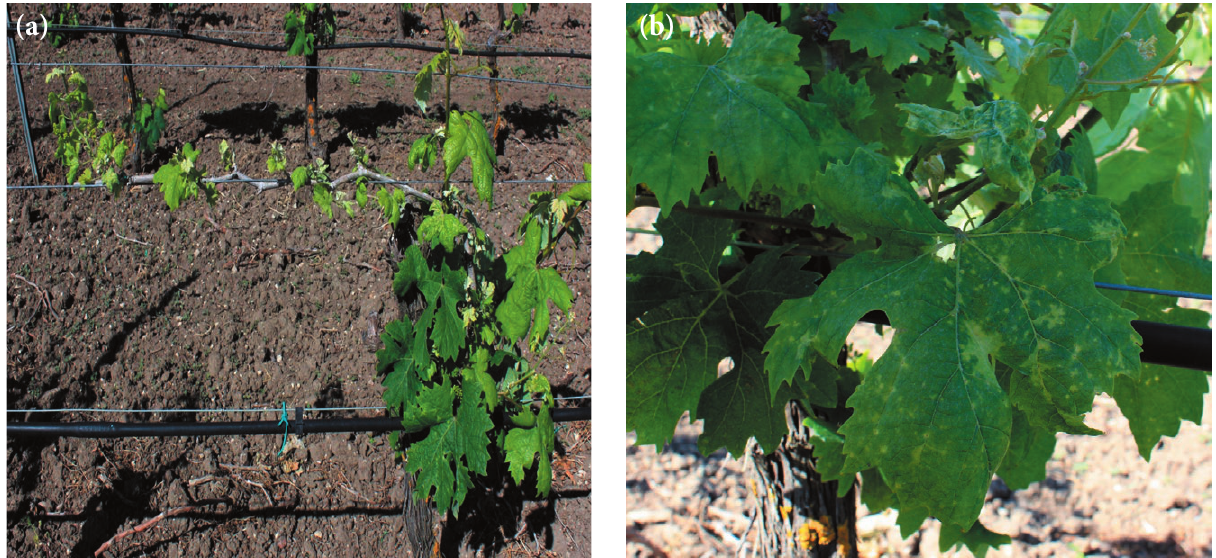
Figure 1. Typical symptoms of chlorotic leaf mottling and deformation on a GPGV-infected ‘Vermentino’ grapevine. Stunted shoots with short internodes (a), mosaics, chlorotic pitting and curling of leaves (b).